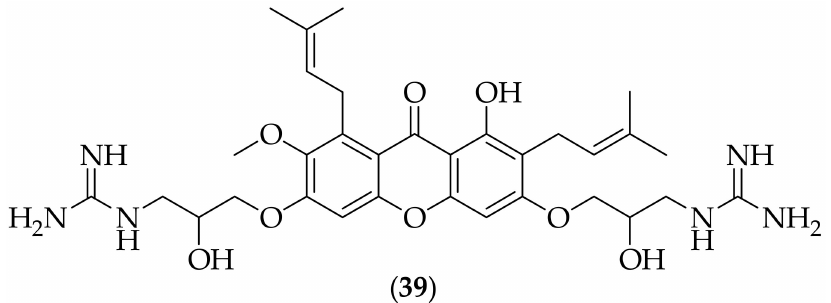
Figure 24. α -Mangostin derived antifungal analog ( 39 ).